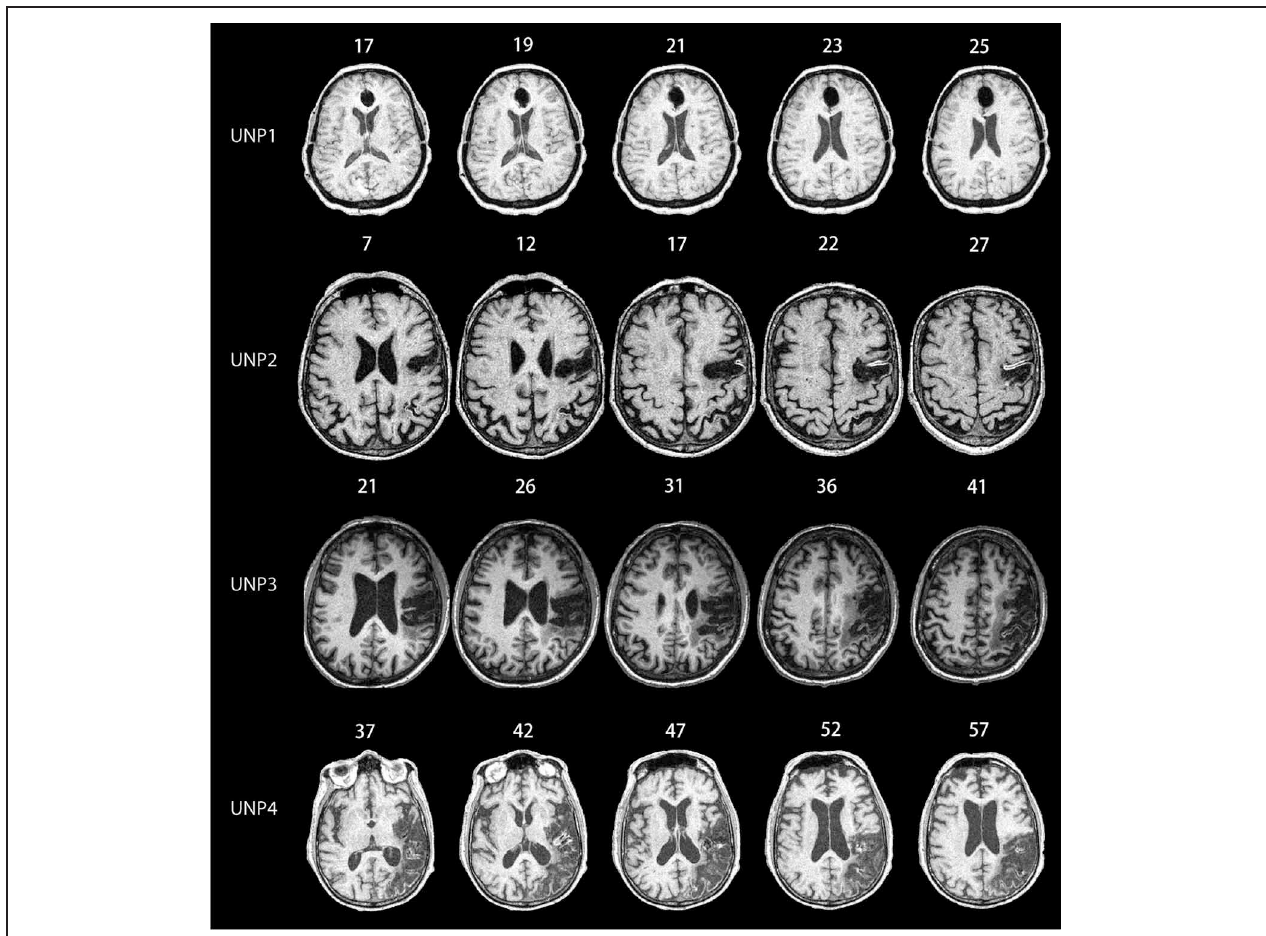
FIGURE 1 | MRI scans for all of the unilateral neglect patients (UNPs) included in the study. Numbers listed above each picture depict the MNI coordinates. UNP1 has lesions in the anterior cingulate, orbitofrontal, and thalamic regions. UNP2 has lesions in the frontal, parietal, and occipital